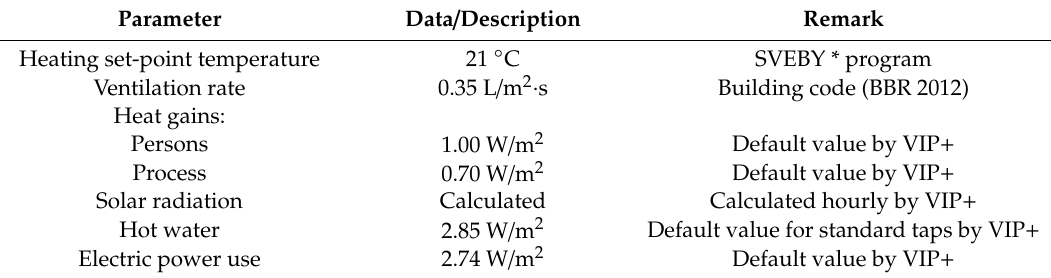
Table 9. Main values and assumptions for the energy balance